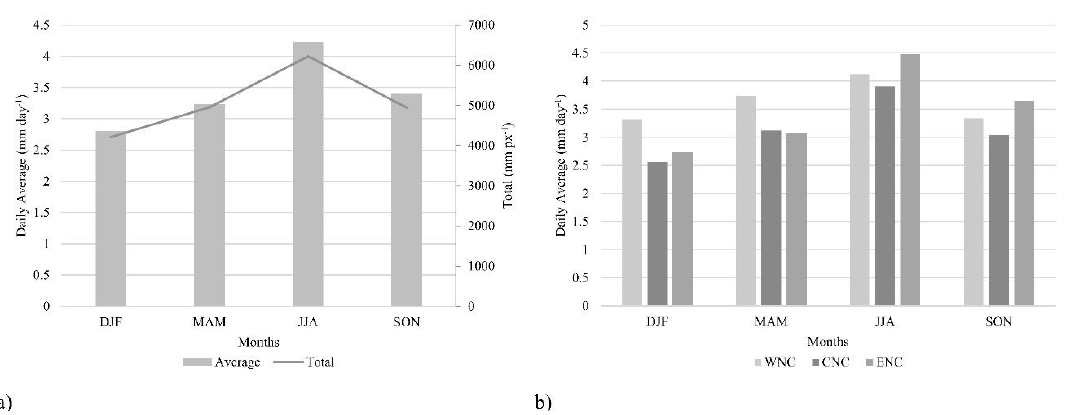
Figure 2. ( a ) Statewide precipitation daily average and total precipitation and ( b ) regional assessment of daily average precipitation for western North Carolina (WNC), central North Carolina (CNC), and eastern North Carolina (ENC). Totals are presented as millimeters per pixel (mm px − 1 ), which is equivalent to millimeters per grid cell.